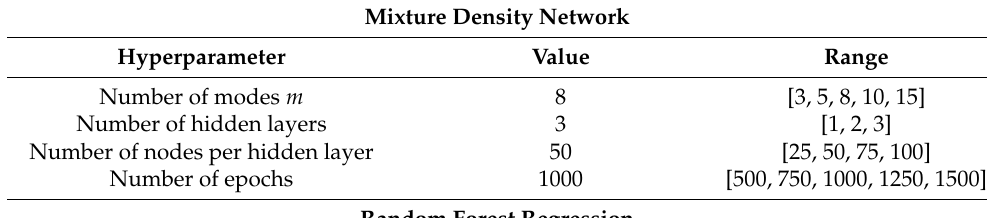
Table 3. Hyperparameters for MDN and